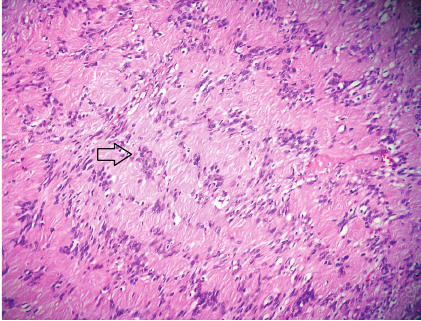
Figure 2: Tumor cells’ nuclei arranged in a palisading fashion (Verocay body, open arrow) (H&E, ×